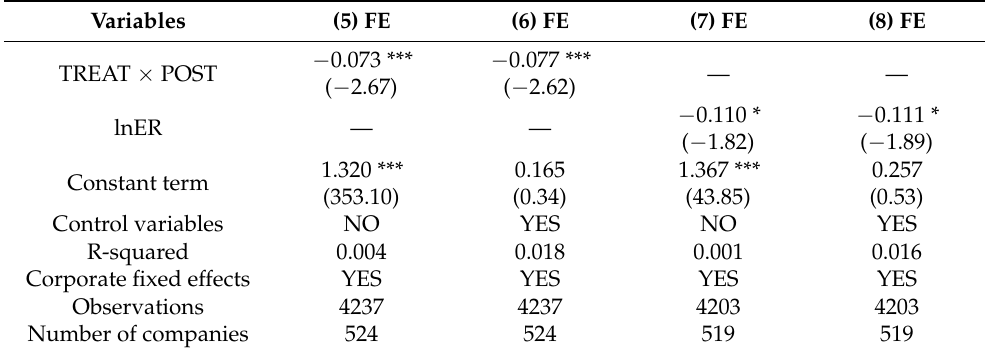
Table 5. Robustness test